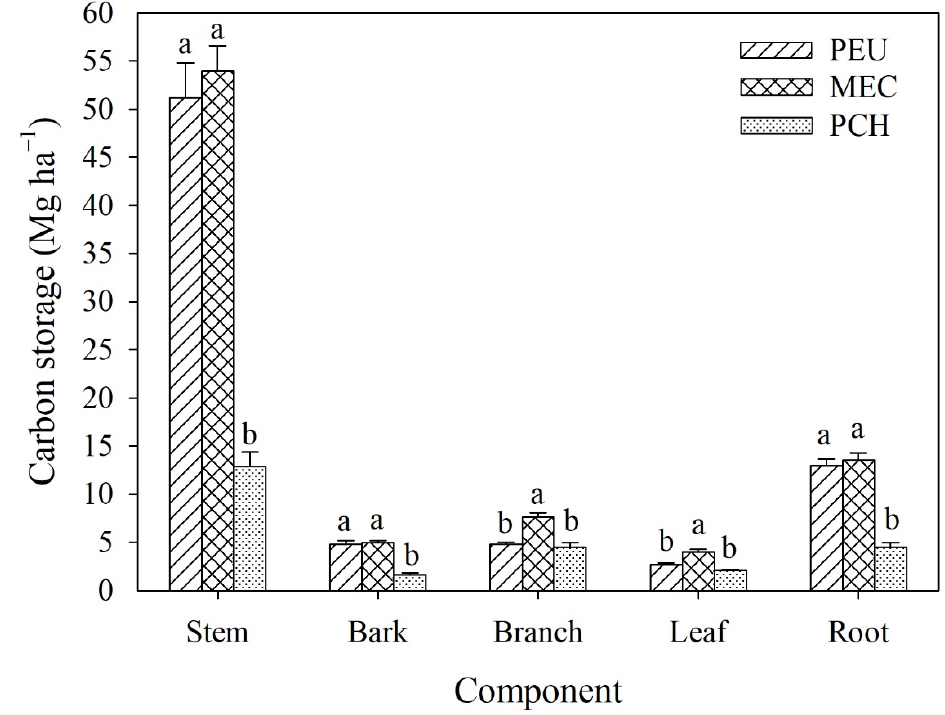
Figure 2. Carbon storage in stem, bark, branch, leaf, and root parts of the tree layer in the different plantations (mean ± SE, n = 5). Different letters indicate significant differences (one-way ANOVA, p < 0.05, least square difference analysis) among different plantations.